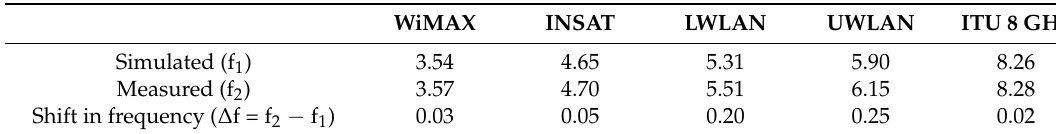
Table 2. Discrepancies between the simulated and measured results.